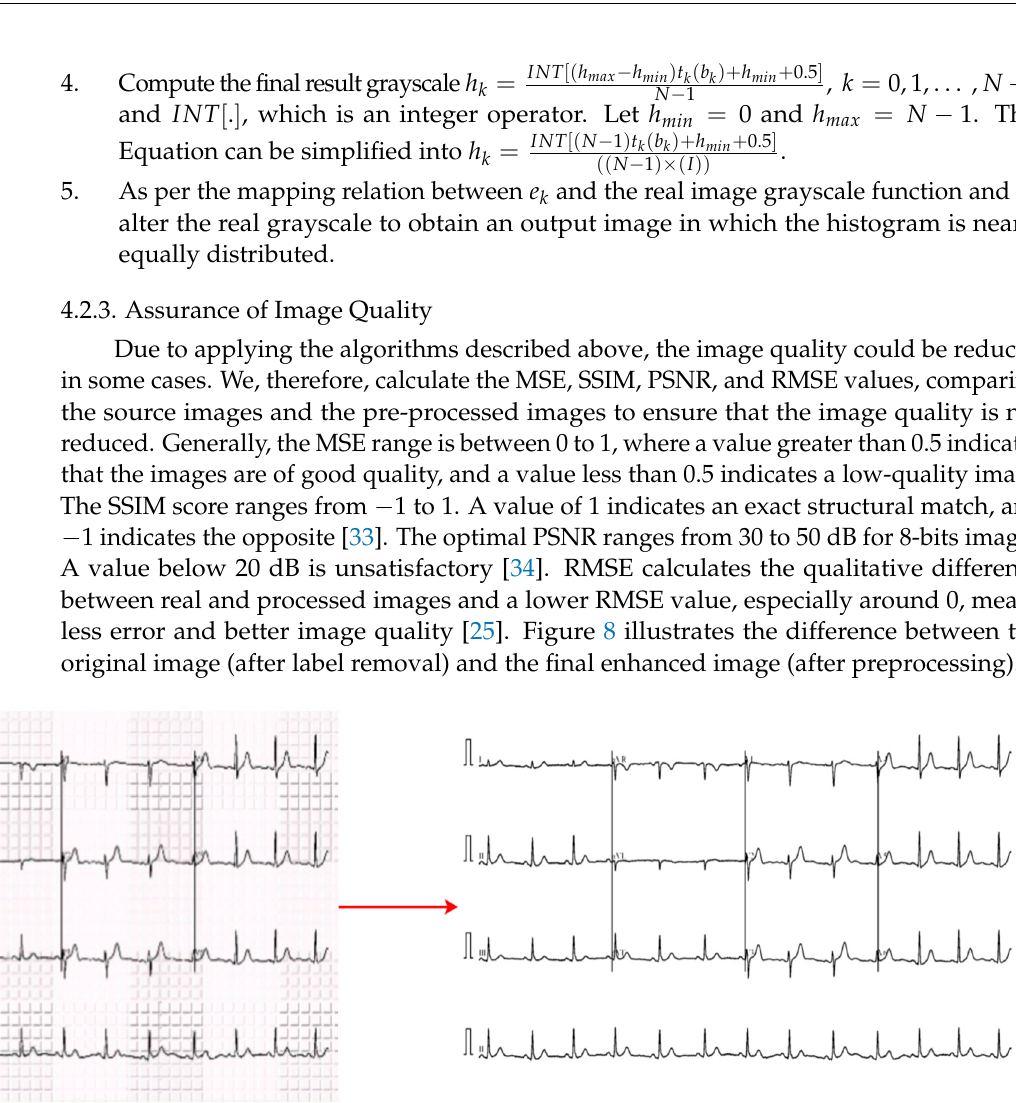
Figure 7. Enhance image quality using HE techniques.